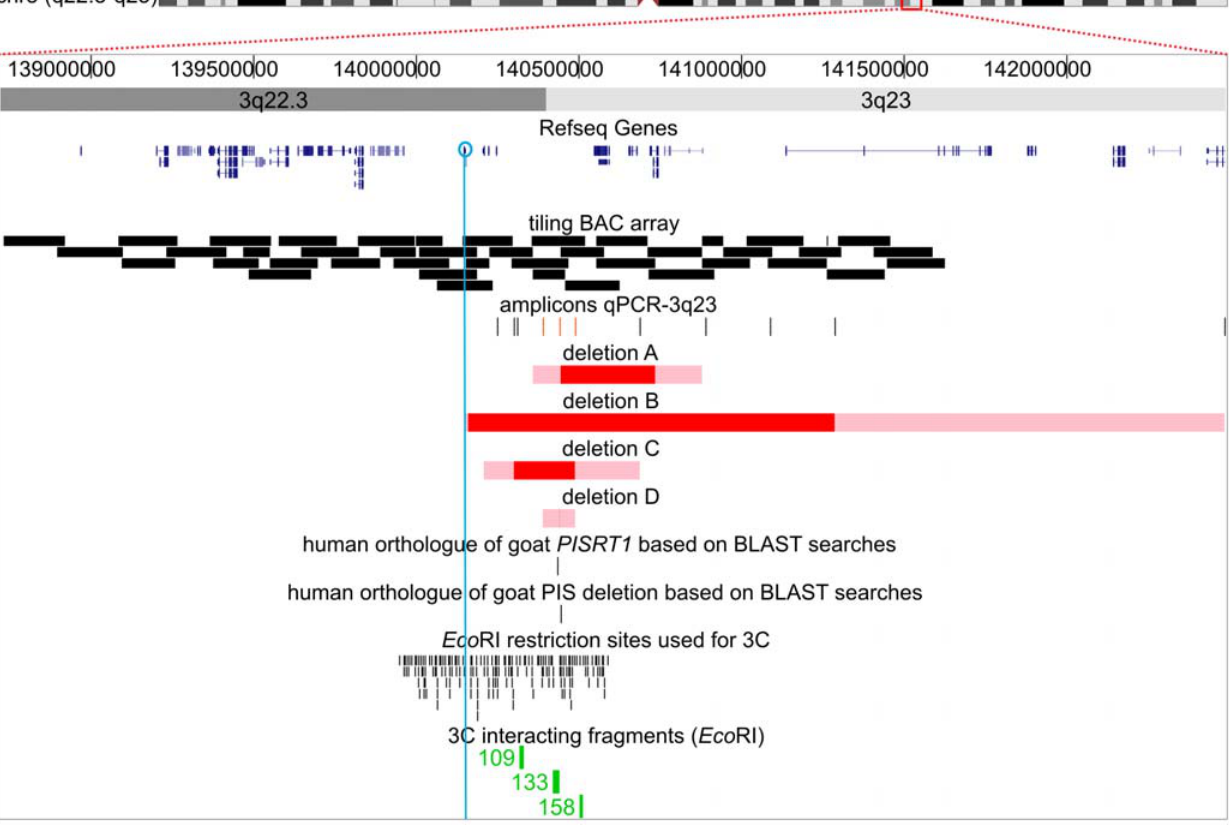
Figure 1. Human Genome Browser view of the FOXL2 region. The FOXL2 region (chr3:138,720,000–143,780,300) with custom tracks showing the BACs and qPCR-3q23 amplicons used in the study. Locations and sizes of the novel deletions are indicated by horizontal bars. The red bars indicate the minimal deleted regions and the pink bars indicate the regions harbouring deletion breakpoints. Two tracks indicate the human orthologous regions of caprine PISRT1 and the caprine PIS deletion based on BLAST searches. The last two tracks at the bottom represent the Eco RI restriction sites used for 3C and the 3C fragments interacting with the fragment containing the FOXL2 promotor (in green). The figure was drawn according to the UCSC, Human Genome Browser, March 2006.